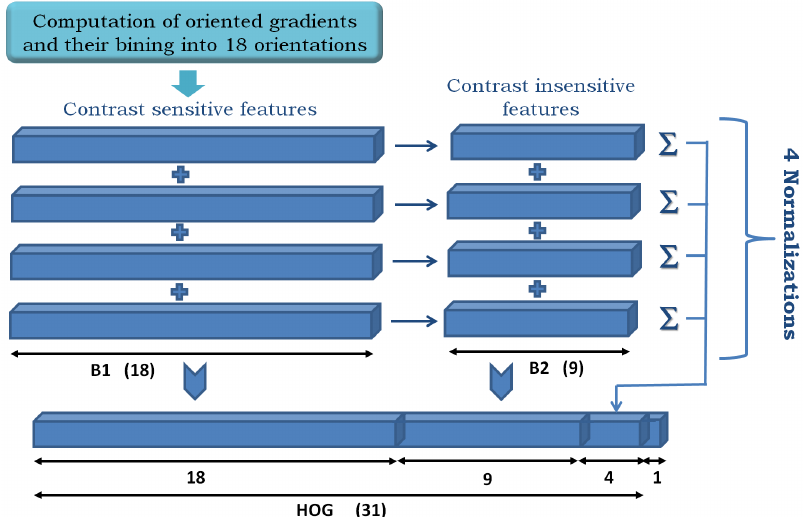
Figure 5. Modified HOG (Histogram of Oriented Gradients) [6]. The histograms